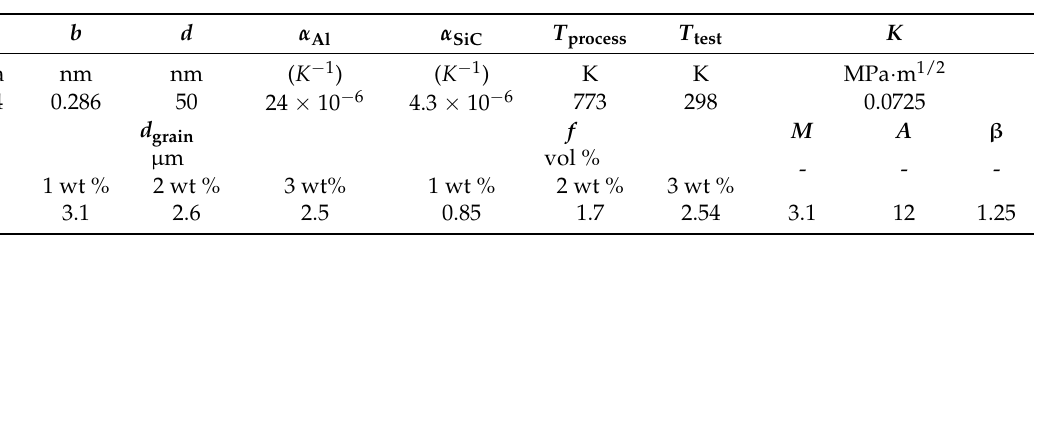
Table 2. Parameters for calculating the contribution of different strengthening